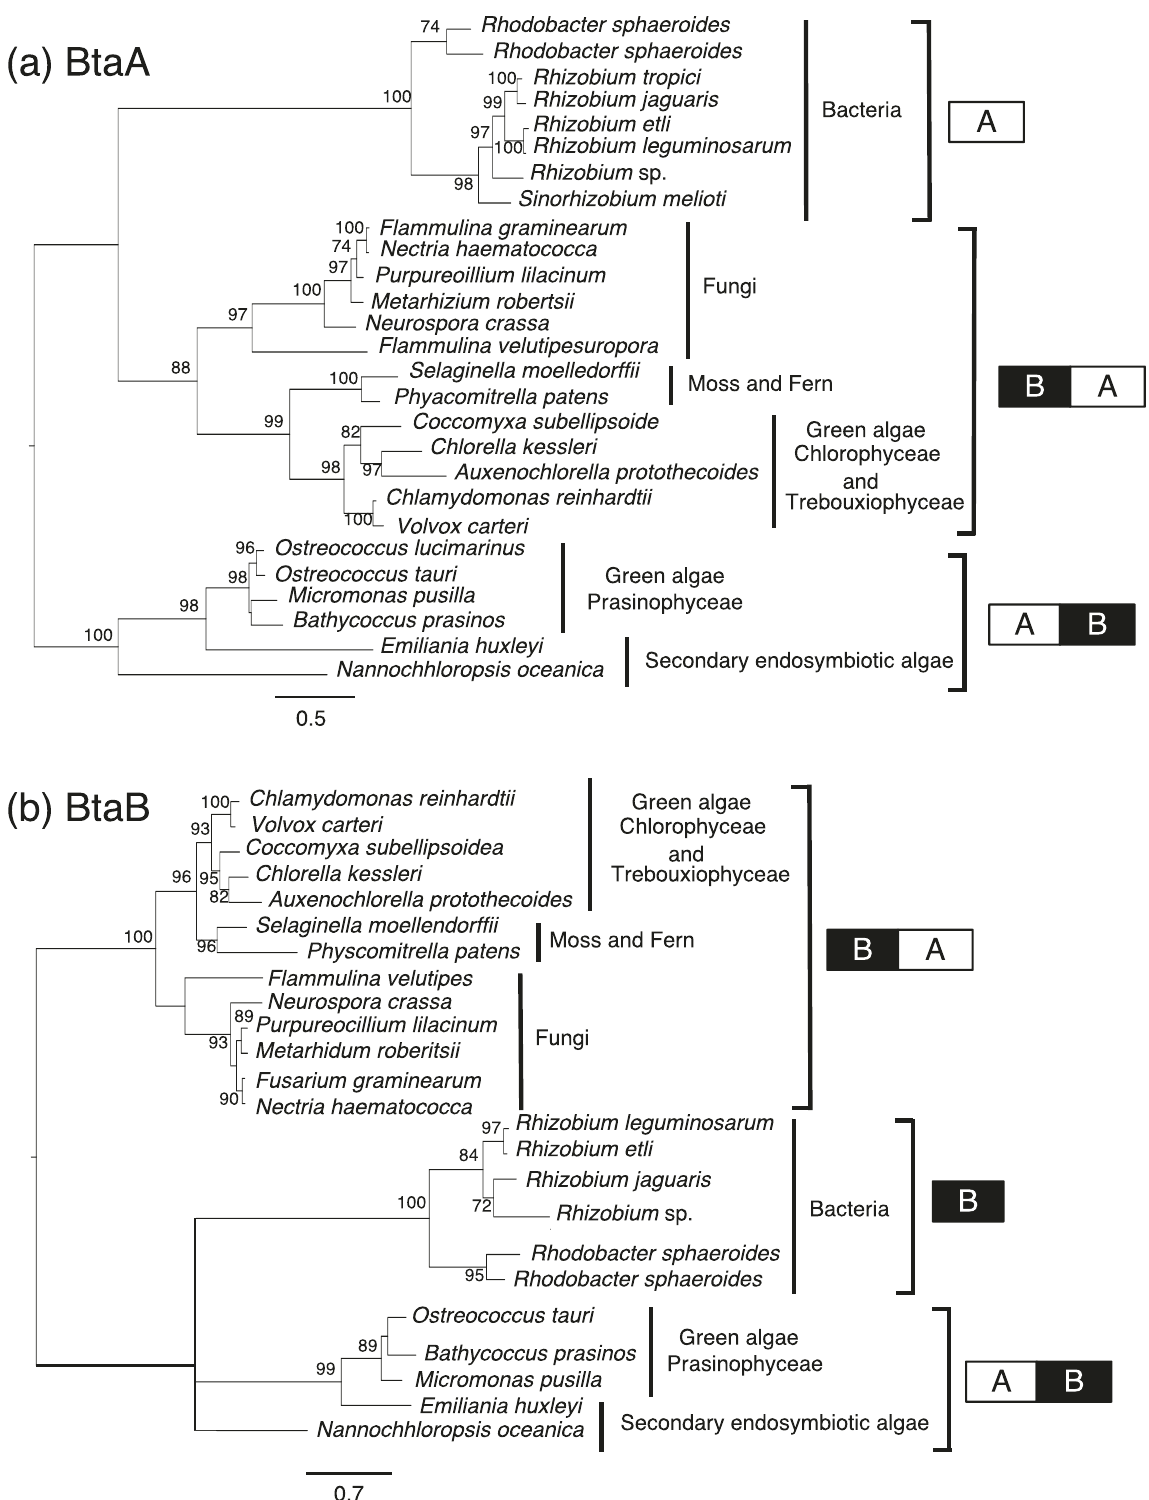
Fig. 8 Phylogenetic trees of the BtaA and BtaB domains in BTA1 proteins. a Bacterial BtaA and eukaryotic BtaA-domains. b Bacterial BtaB and eukaryotic BtaB-domains. Two linked boxes, AB and BA, indicate eukaryotic A and B type BTA1 proteins, respectively, whereas single boxes, A and B, demonstrate bacterial BtaA and BtaB proteins,